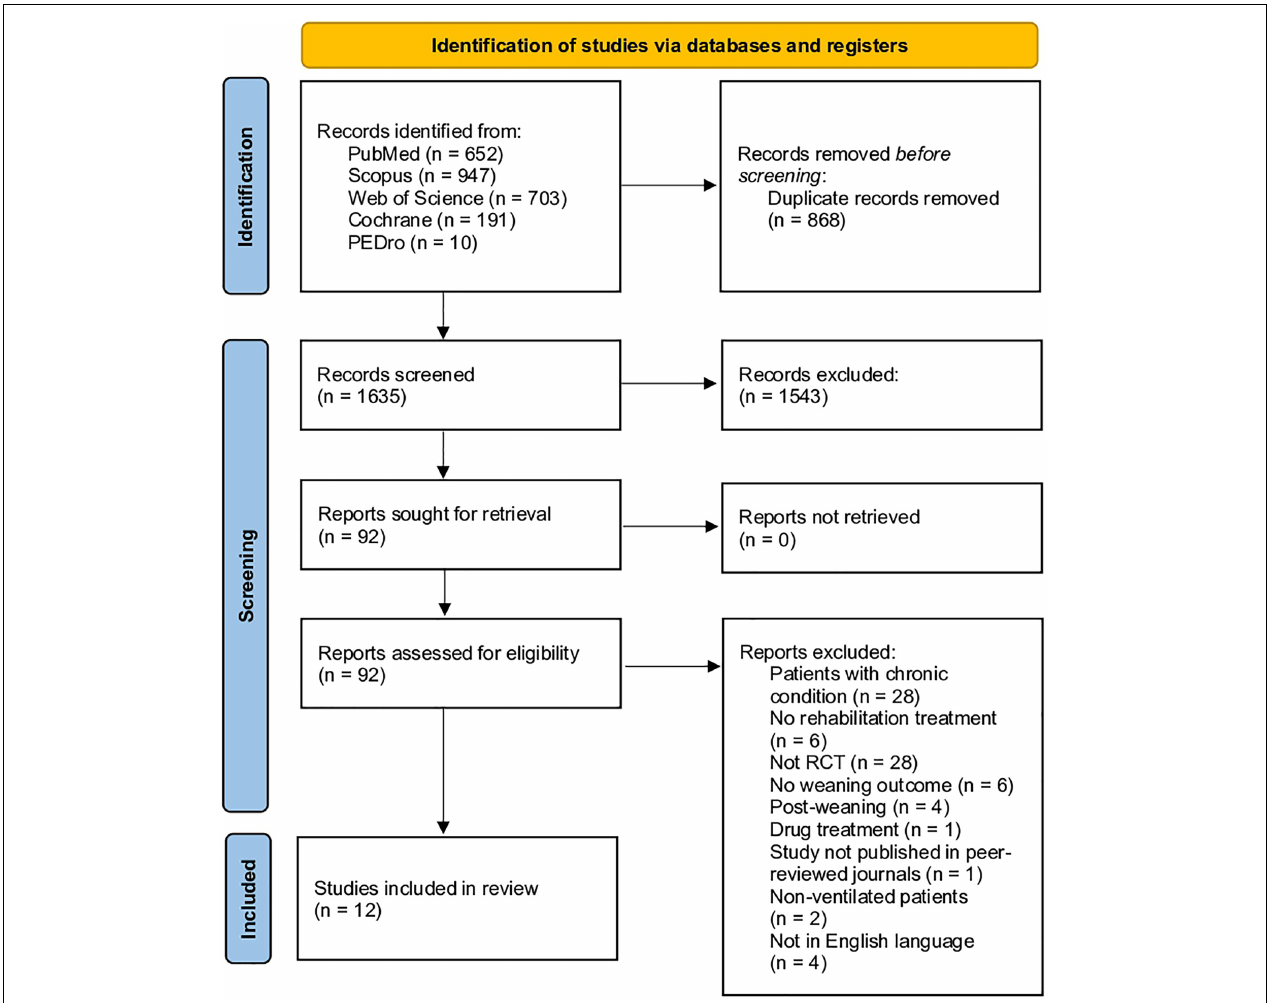
FIGURE 1 | PRISMA 2020 flow